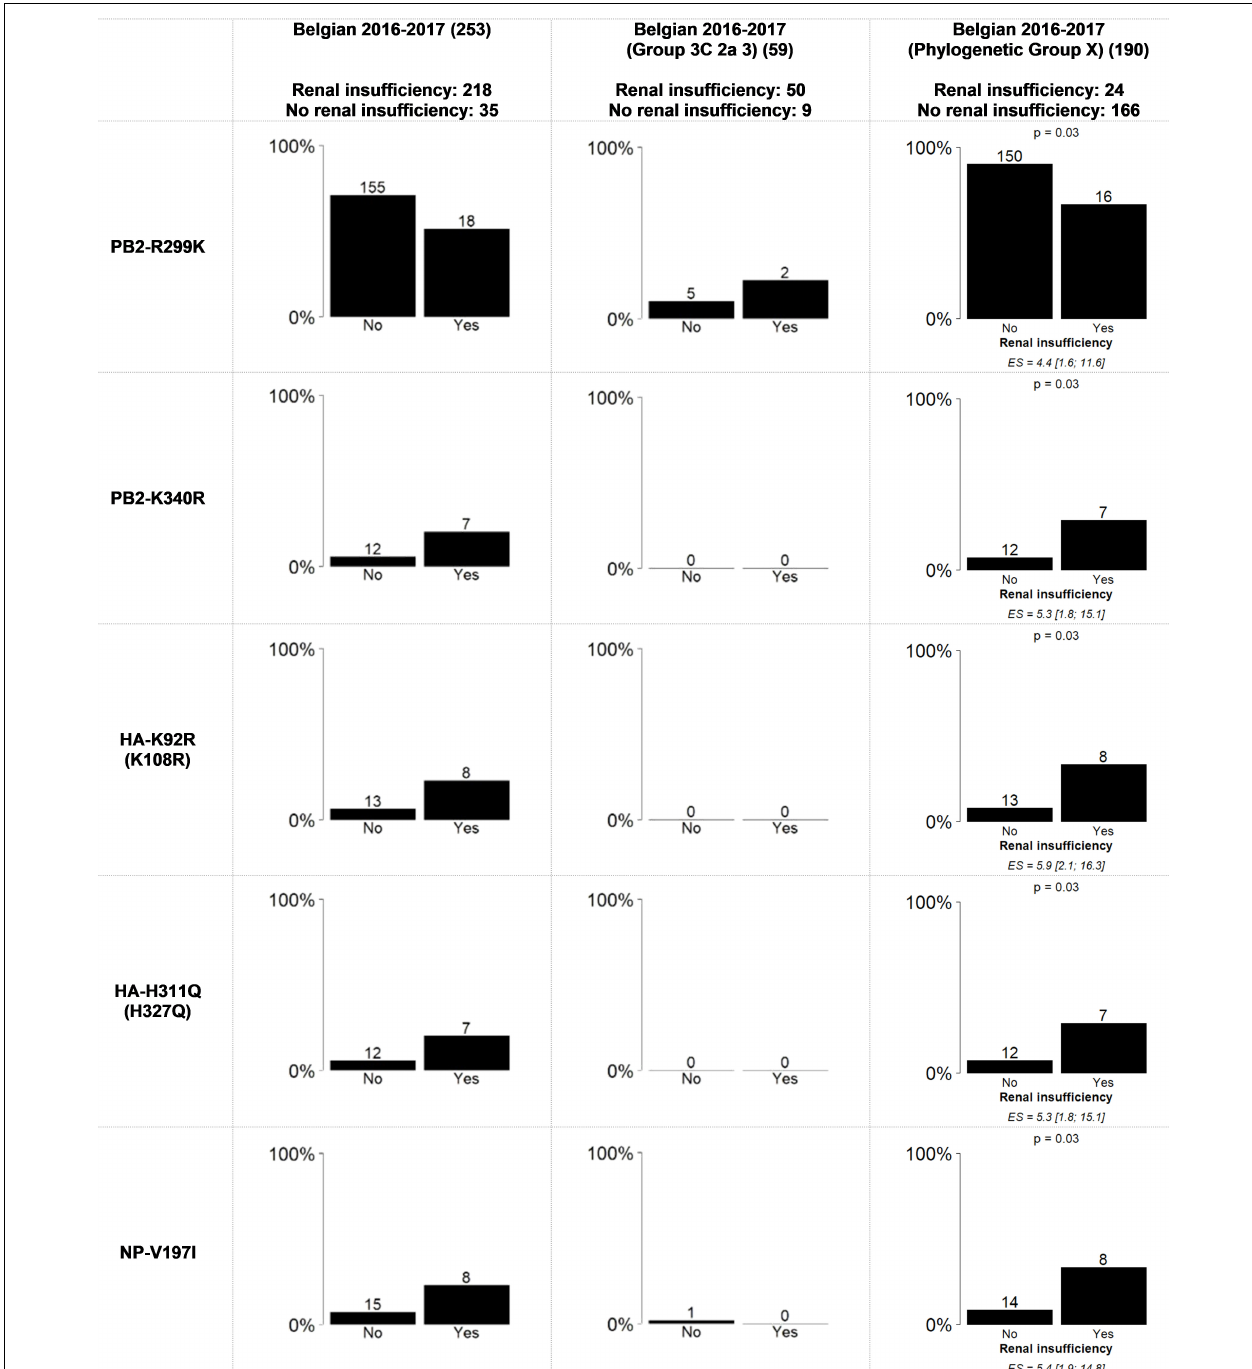
FIGURE 3 | Statically significant results using the Fisher’s exact test with FDR correction for the association between renal insufficiency and amino acid mutations in the whole genome from all of the samples and “Phylogenetic Group X” and “Group 3C2a3”. “Phylogenetic Group X” includes “Group 3C2a1”, “Group 3C2a1(2)”, “Group 3C2a1a”, “Group 3C2a1a (2)”, “Group 3C2a1b”, “Group 3C2a2”, “Group X”, “WGX” and “WGY”. The bar graphs represent the percentage of samples per variable of the patient data that have the mutation. On top of the bars the number of samples that had this mutation are indicated. The magnitude of the significant association is defined by the effect size (ES) and its confidence interval. The resulting p-value of the Fisher’s exact test with FDR correction is indicated above bar charts for which significant associations were found.